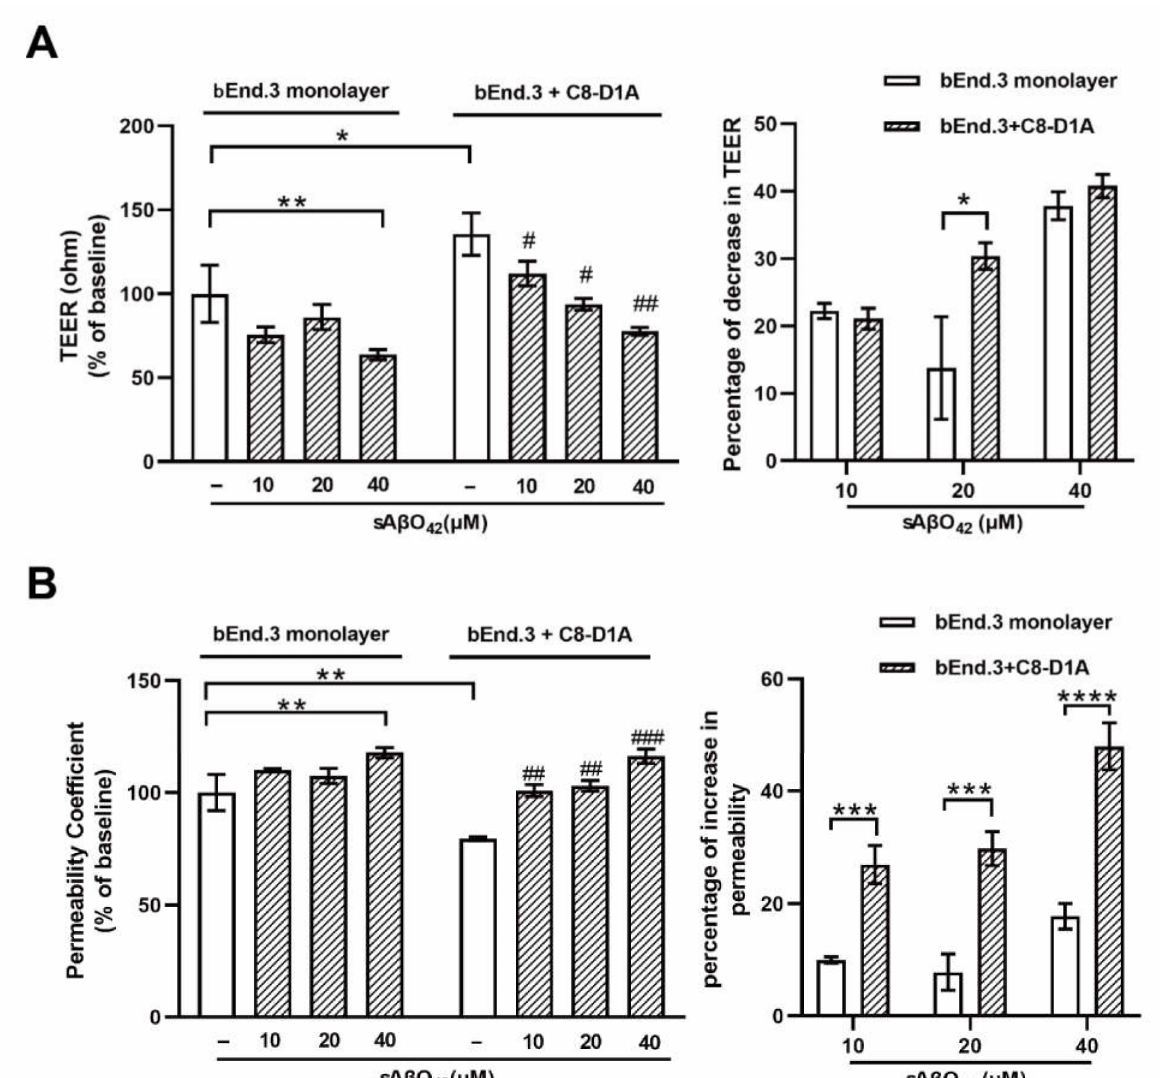
Figure 8. Barrier disruptions induced by murine sA β O42 were enhanced in the bEnd.3 + C8-D1A co culture. ( A ) TEER value and permeability of ( B ) FITC-dextran across the bEnd.3 monolayer and bilayer of the bEnd.3 + C8-D1A co culture system. Data are shown as means ± SD of at least three independent experiments and were analyzed by one-way ANOVA followed by a post hoc Dunnett’s test. * p ≤ 0.1, ** p ≤ 0.01, *** p ≤ 0.001, **** p ≤ 0.0001 vs. control group. # p ≤ 0.1, ## p ≤ 0.01, ### p ≤ 0.001 vs. control group in the bEnd.3 + C8-D1A